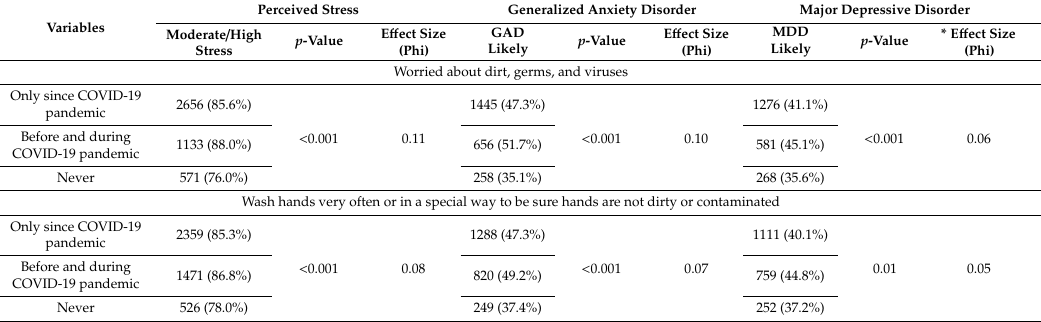
Table 4. Chi-Square test of association between obsessive-compulsive symptoms and perceived stress, likely GAD and likely